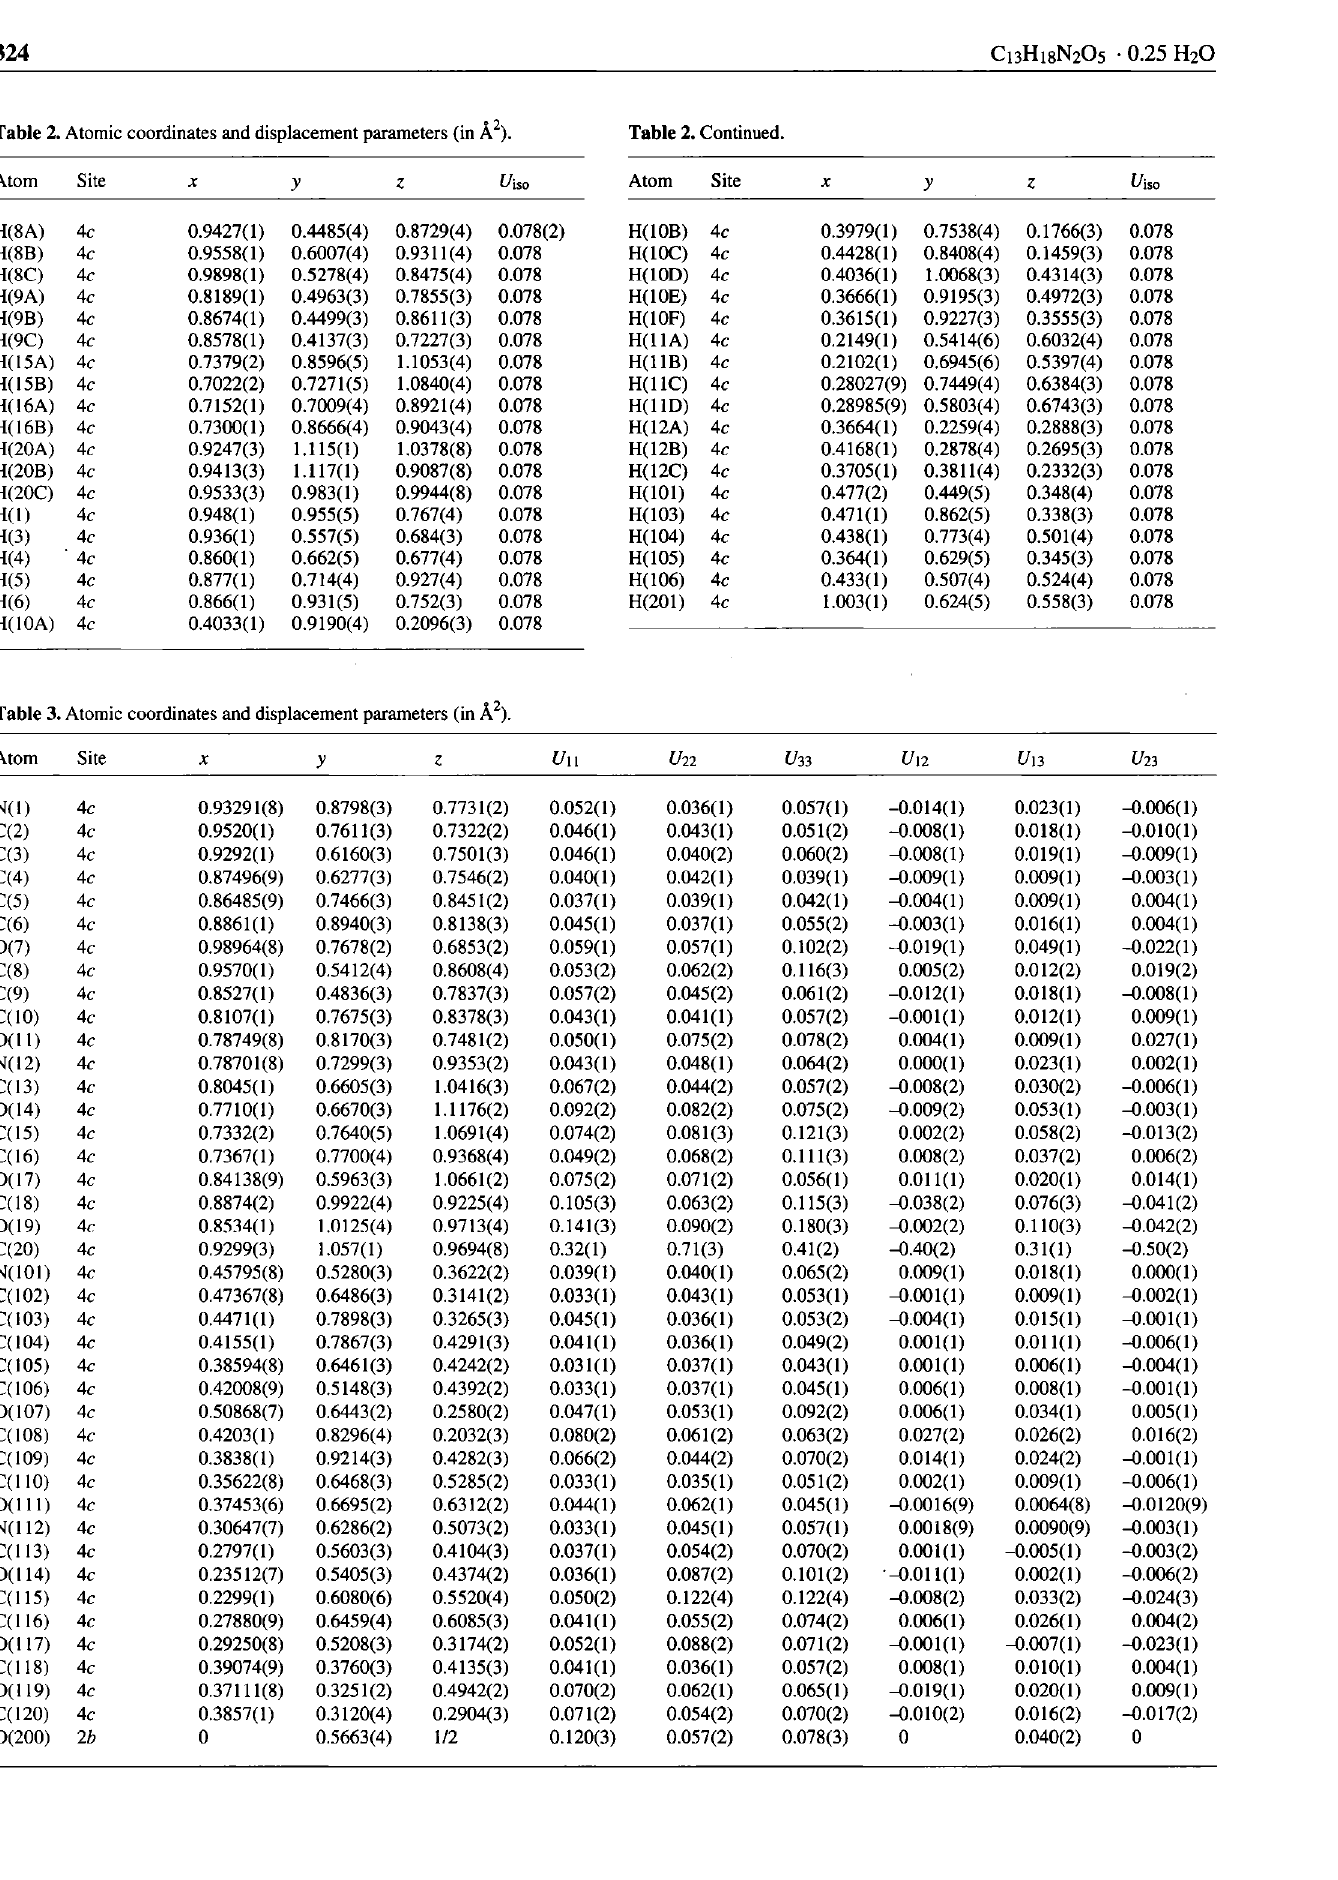
Table 2. Atomic coordinates and displacement parameters (in Â 2 ). Table 2. Continued.